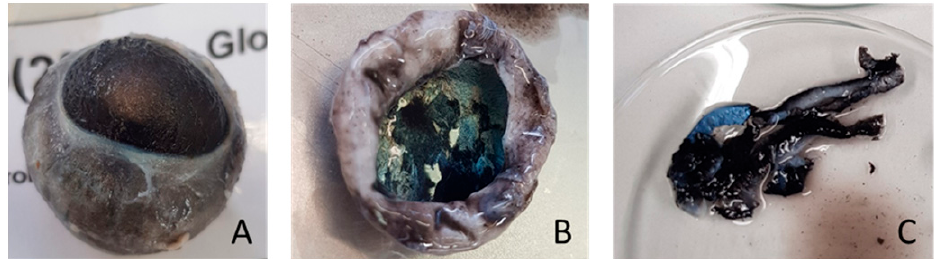
Figure 2. Dissection of the right eyeball of one lamb. From left to right: ( A ) right eyeball; ( B ) removal of eye structures (cornea, iris and lens) and tapetum lucidum evidenced; and ( C ) cutting of material used for FA analysis including tapetum lucidum and retina tissues.